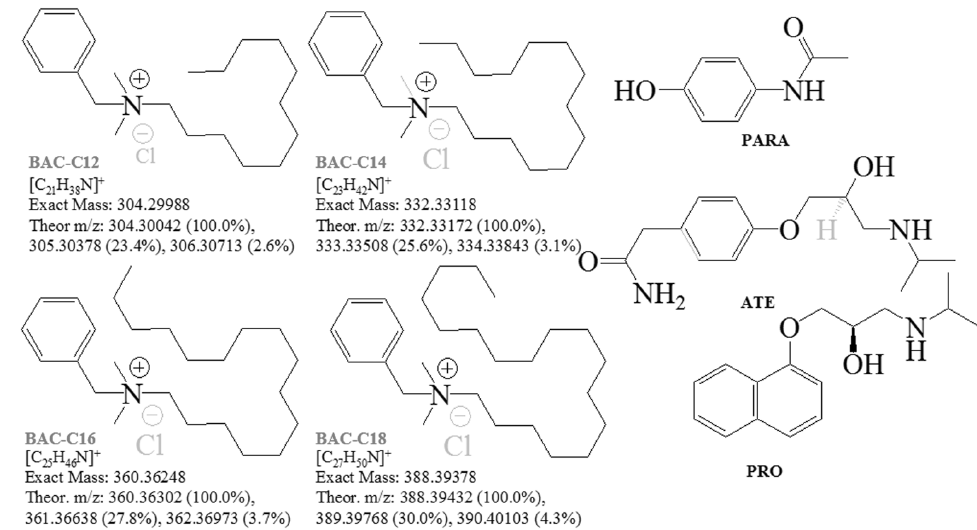
Figure 1. Chemical diagrams of benzalkonium chlorides and pharmaceutics; exact masses’ theoretical m / z data in cationic form [M] + ; theoretical mass spectrometric isotopic compositions and intensity ratios of the isotope shapes .